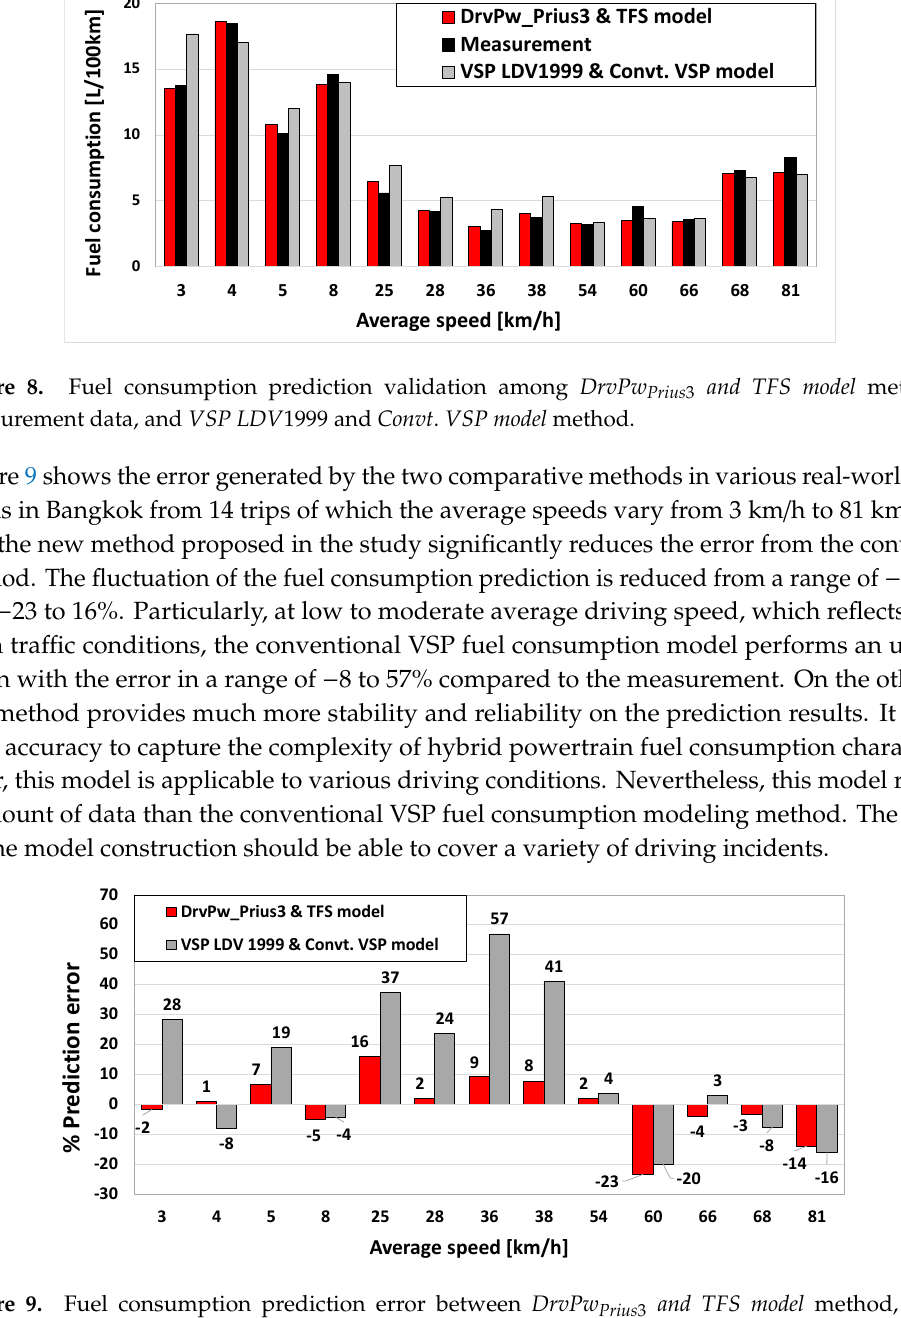
Figure 9. Fuel consumption prediction error between DrvPw Prius 3 and TFS model method, and Figure 9 Fuel consumption prediction error between 𝑫𝒓𝒗𝑷𝒘 𝑷𝒓𝒊𝒖𝒔𝟑 𝐚𝐧𝐝 𝑻𝑭𝑺 𝒎𝒐𝒅𝒆𝒍 method, and VSP LDV 1999 and Convt . VSP model 𝑽𝑺𝑷 𝑳𝑫𝑽𝟏𝟗𝟗𝟗 and 𝑪𝒐𝒏𝒗𝒕.𝑽𝑺𝑷 𝒎𝒐𝒅𝒆𝒍 method.